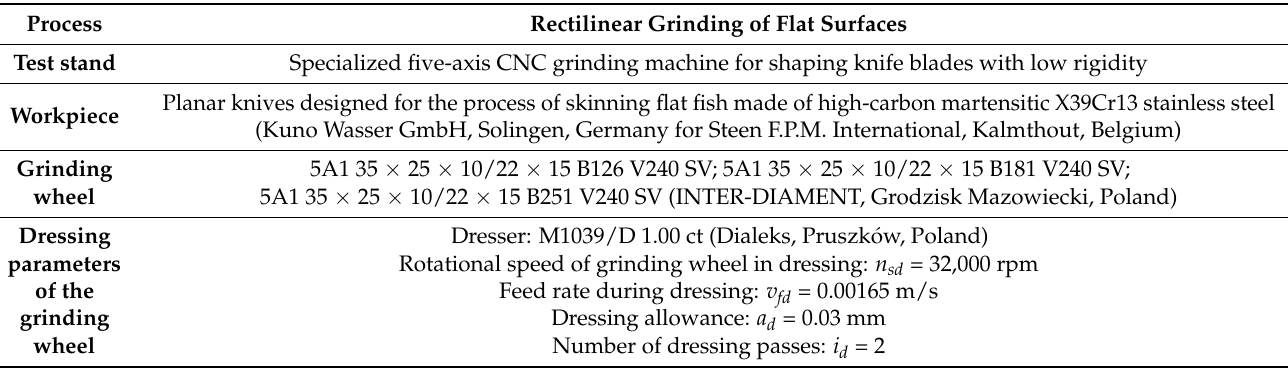
Table 4. Specification of parameters and conditions of experimental tests.